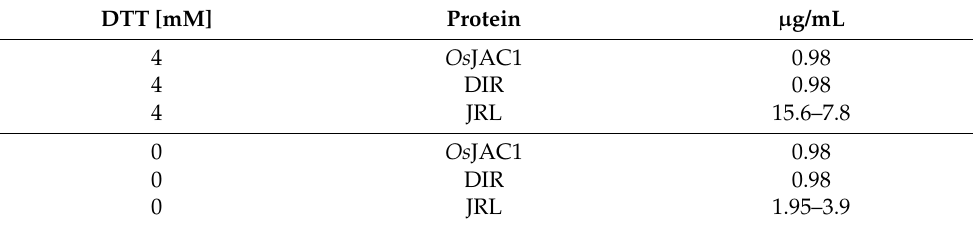
Table 3. Overview of the hemagglutination assay, using rabbit erythrocytes with Os JAC1 and its domains. Data represents the lowest determined protein concentrations capable of agglutinating